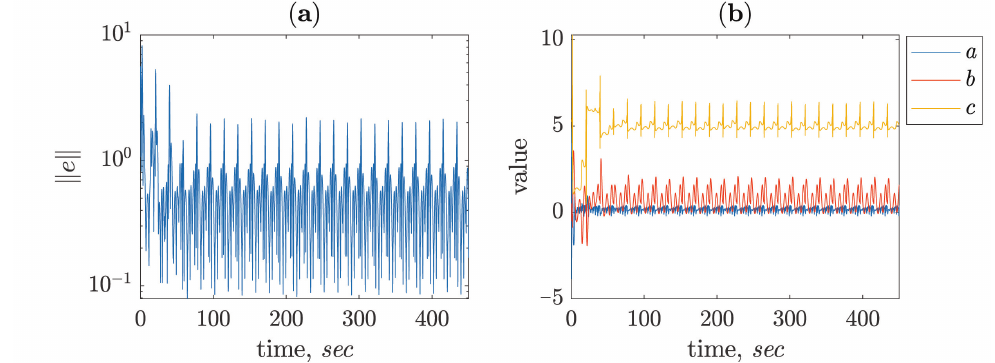
Figure 8. ( a ) Synchronization error between circuit and computer model. ( b ) Evaluation of parameters for the slave system.